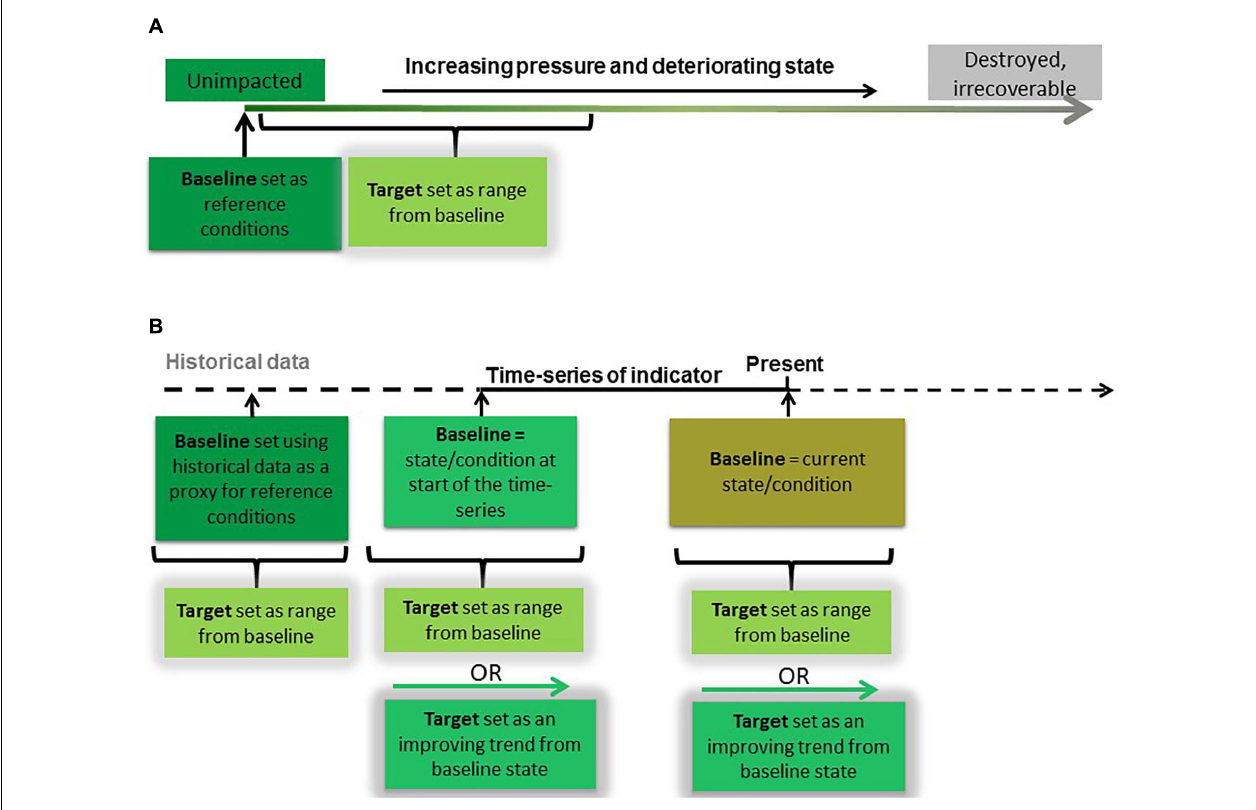
FIGURE 2 | Establishing baselines and setting targets under two scenarios of biodiversity data availability. (A) The relative condition of the indicator is known, with data available representing unimpacted conditions (reference conditions). In this case, an indicator target can be set as a range of indicator values within a specified distance from the baseline reference conditions. (B) The relative condition of the indicator is not known, and no data representing reference conditions are available. In this case, time-series data are used to establish baseline conditions and set targets. Baselines can be set using (1) historical data, such as from an alternative data source or model, (2) the earliest time-series data available, or (3) data representing current conditions. Targets can then be set as a range or as an ‘improving’ trend from baseline